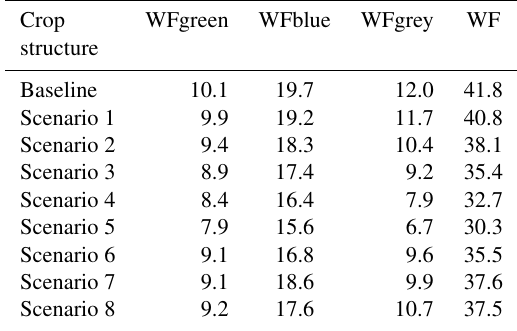
Table 6. WF (km 3 ) of different crop structure scenarios in the Hebei southern